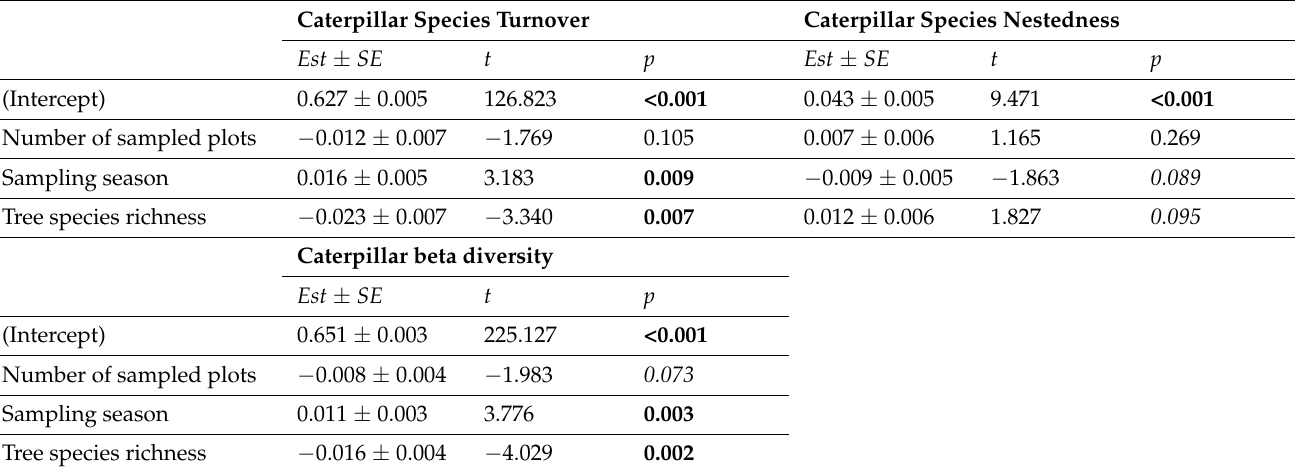
Table A2. Summary of linear model testing of changes in beta diversity estimates between tree species. Analysis run similarly for overall beta diversity and its two components. All factors are scaled by subtracting the mean and dividing by standard deviation. Response factors and number of sampled plots are log + 1 transformed. Standardized parameter estimates (with standard errors, t, and p -values) are shown for explanatory variables. p -values in bold mean p ≤ 0.05, p -values of italic mean p ≤